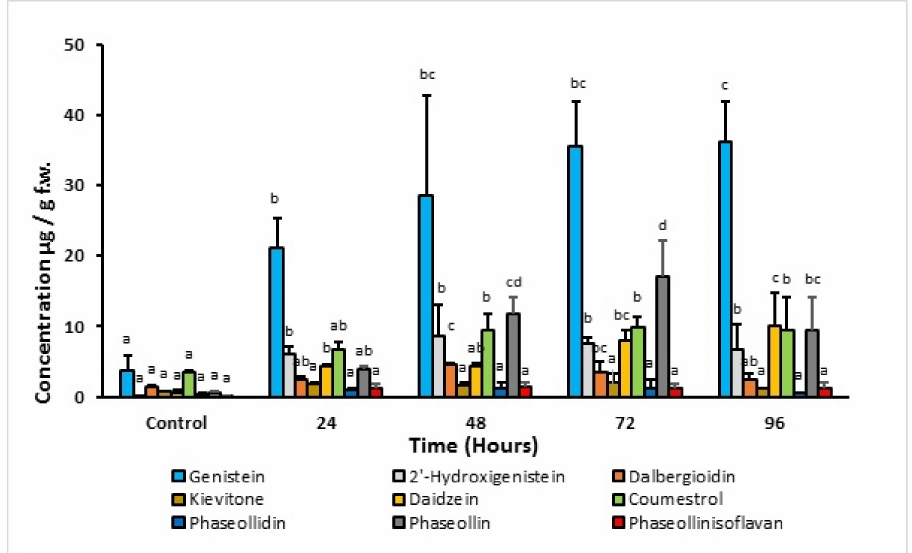
Figure 6. Time-course accumulation of phytoalexins in hypocotyl-root of common bean ( P. vulgaris L. cv. ICA Cerinza) treated with 1.0 mM 1-oxo-indanoyl-L-isoleucyl methyl ester ( 4 ). Bars represent the mean concentrations of the isoflavonoids ± standard deviation ( n = 3). For each compound, bars with different letters (a–d) are significantly different ( p < 0.05; Fisher’s LSD